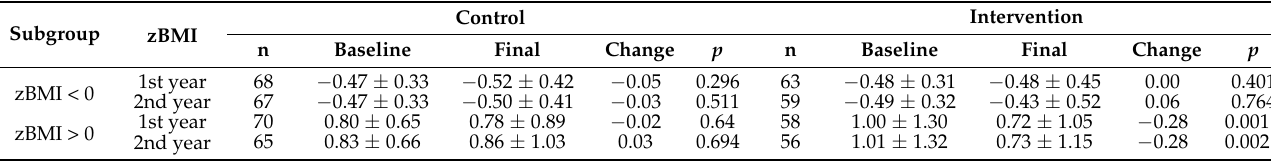
Table 3. Evolution of body mass index z-score (zBMI) in the participants of the control and intervention groups stratified according to the baseline zBMI of the students.